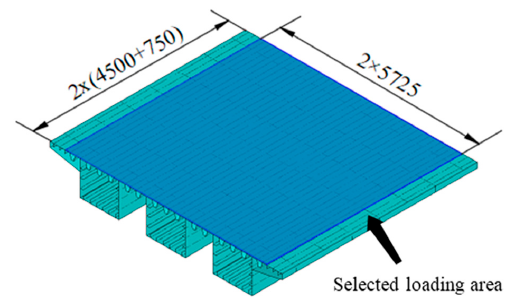
Figure 9. Loading area selected for analysis.